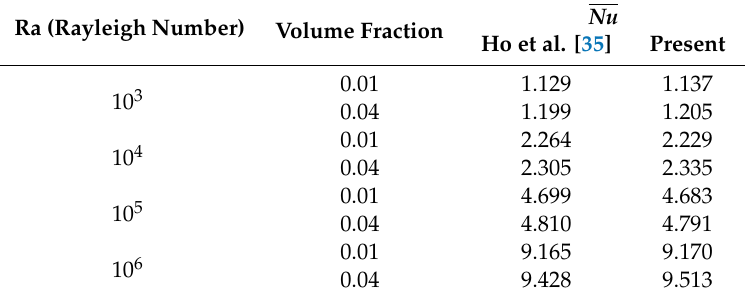
Table 1. Comparison of Nu results for free convection of nanoliquids in a square box.